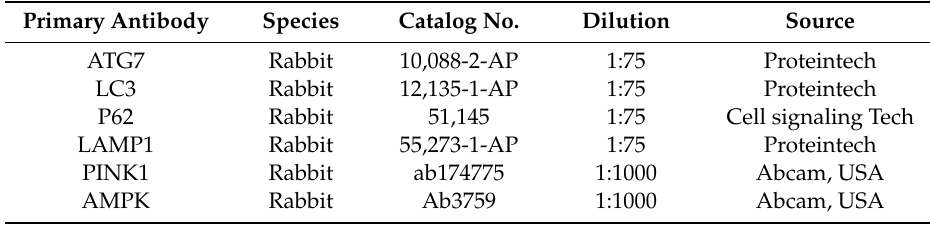
Table 1. Information about primary